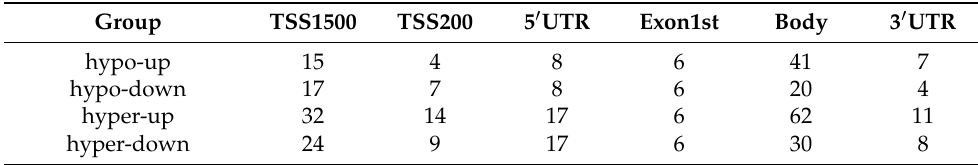
Figure 6. Integrated analysis of the DEGs and DMGs based on the CpGs in different regions. ( A ) Barplot for the CpG distribution of the DMGs. ( B ) Barplot for the overlapped genes between the DEGs and the different regions of the DMGs. The y-axis stands for the overlapped gene numbers. The x-axis represents different gene regions: TSS1500, TSS200, 5 (cid:48) UTR, Exon1st, body, and 3 (cid:48) UTR. ( C ) Barplot of the four groups that overlap in each region. Hyper-up represents the hyper-methylated and up-regulated genes. The y-axis is the number of genes. The x-axis represents different gene regions: TSS1500, TSS200, 5 (cid:48) UTR, Exon1st, body, and 3 (cid:48) UTR. Table 2. Gene numbers of four groups in TSS1500, TSS200, 5 (cid:48) UTR, Exon1st, Body, 3 (cid:48) UTR